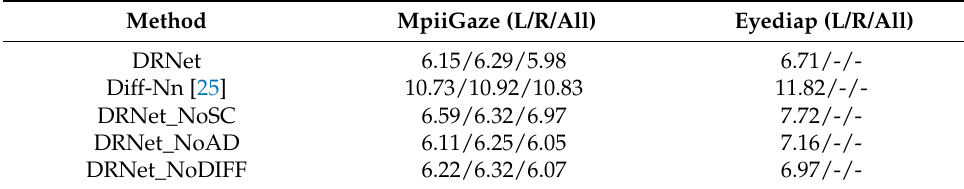
Table 7. The performance of Diff-Nn in common